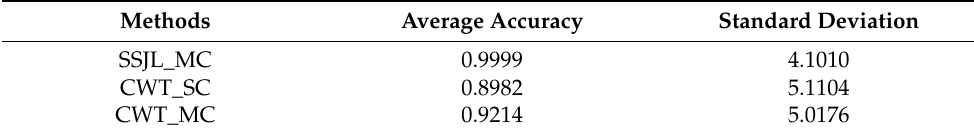
Table 4. Diagnostic results obtained by different data processing